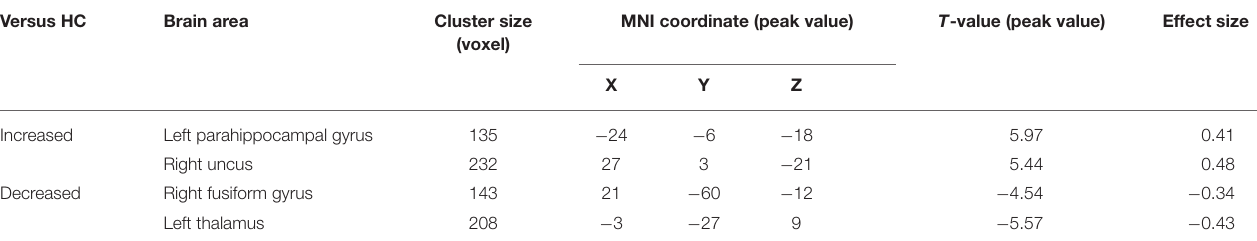
TABLE 2 | ReHo values in non-NPSLE patients.